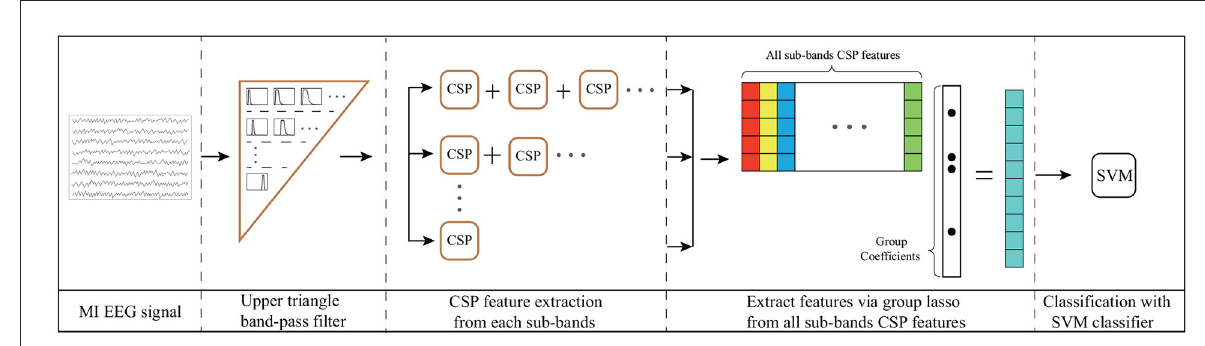
FIGURE3 Architecture of UTFB-SSP algorithm. 1) Upper triangle band-pass filter; 2) CSP feature extraction from each sub-band; 3) Extraction of features via group lasso from all sub-bands of CSP features; 4) Classification via SVM